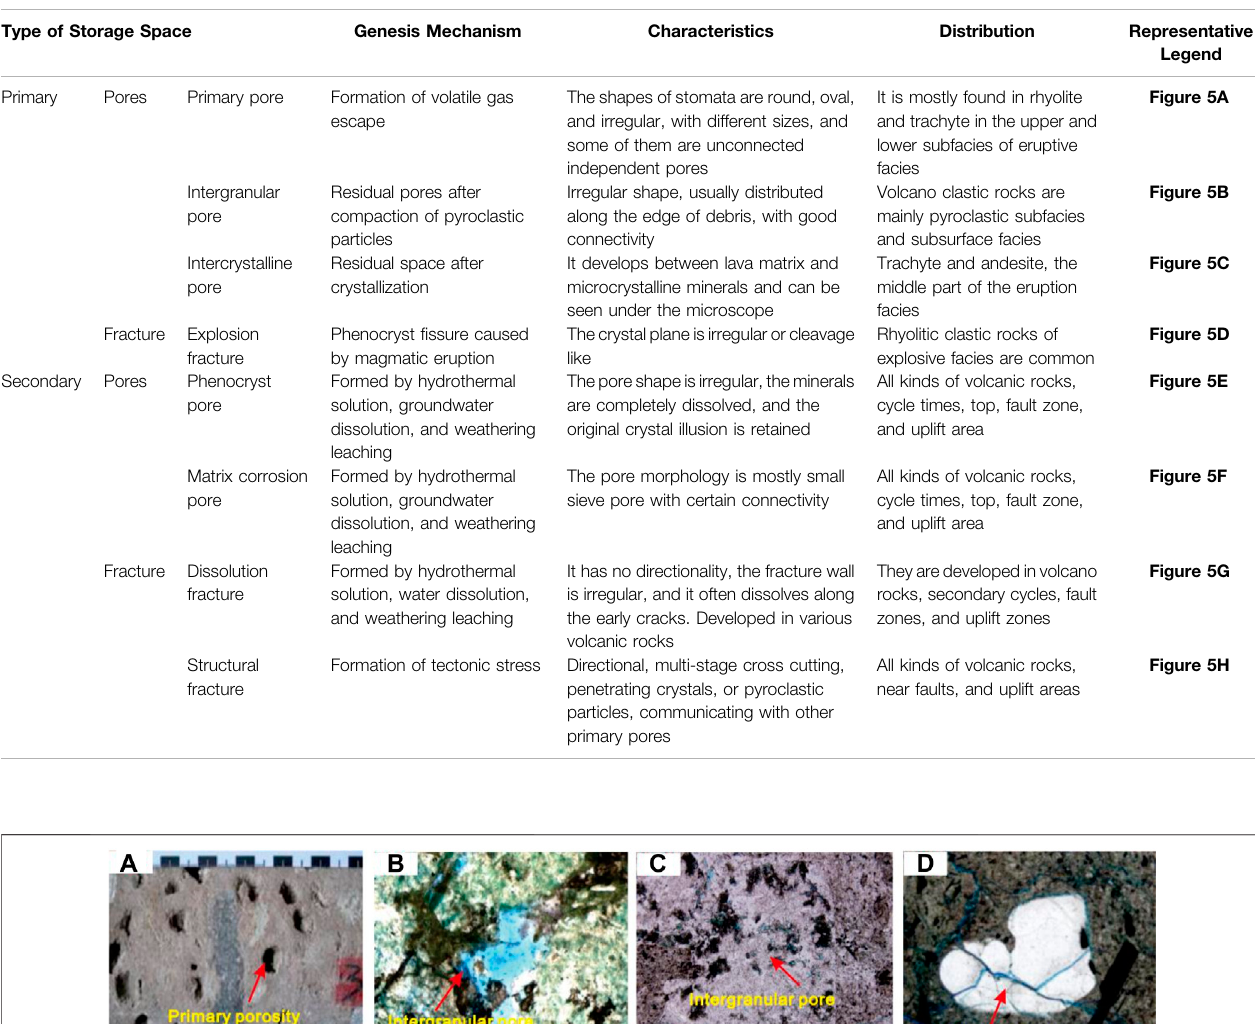
TABLE 1 | Reservoir space types and characteristics of the volcanic rocks in the Huoshiling Formation of the Wangfu gas fi eld in the Songliao basin.